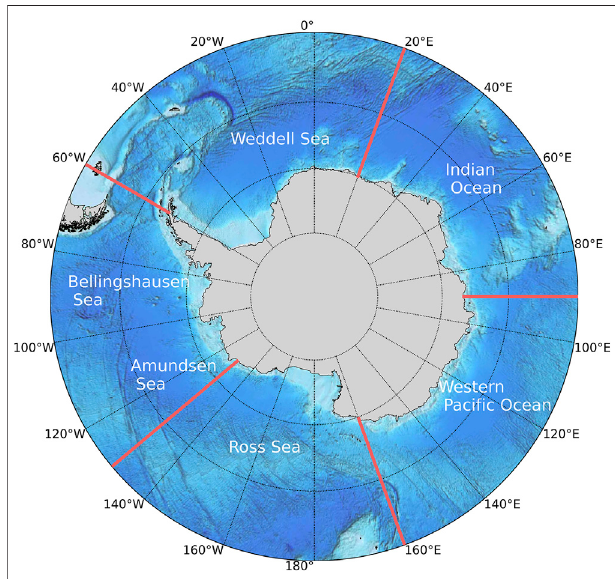
FIGURE 1 | Map of the fi ve Antarctic sectors used in the regional analysis.